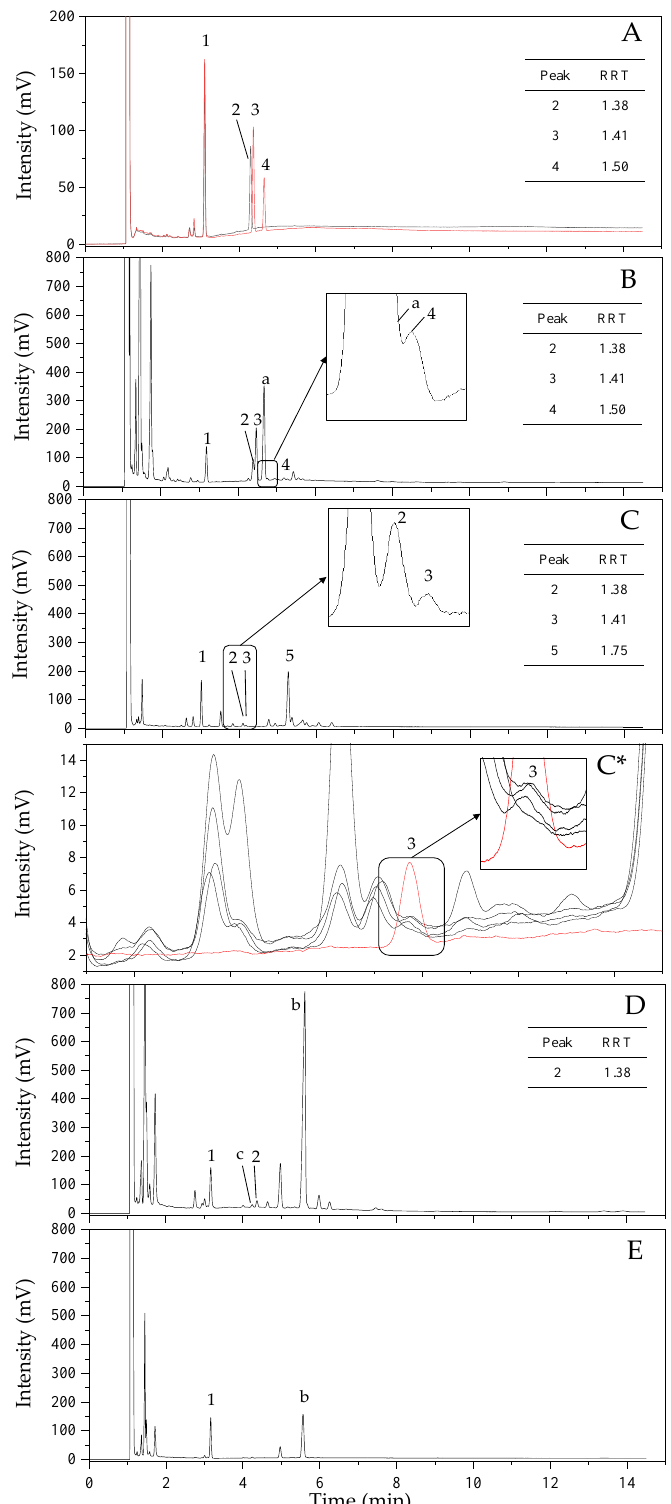
Figure 2. Gas chromatograph-flame ionization detector (GC-FID) chromatogram of a mixed standard (cholesterol, lathosterol, and α -tocopherol) and samples. ( A ), mixed standard; ( B ), Pyropia tenera ; ( C ), perilla seed oil; ( C * ), cholesterol peak of four perilla seed oil samples; ( D ), Saccharina japonica ; ( E ), Undaria pinnatifida. Peak identification: 1, 5- α -cholestane (IS); 2, α -tocopherol; 3, cholesterol; 4, lathosterol; 5, β -sitosterol a-b, unknown peak; c, unknown peak (RRT: 1.35) around lathosterol and cholesterol. Relative retention time (RRT): value obtained by dividing the compound retention time by the internal standard retention time.